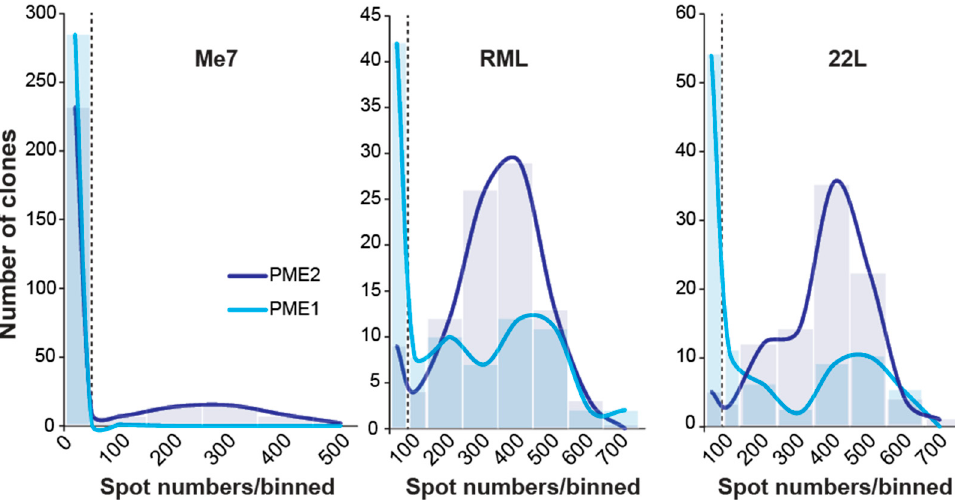
Figure 1. Distribution of prion-infected PME1 and PME2 sublines following infection with Me7, RML and 22L. Cultures of PME1 and PME2 cells were challenged with a 10 − 3 dilution of mouse-adapted prion strain homogenates Me7, RML and 22L (10% w / v ). Cells were split 1:8 twice a week to dilute out the inoculum. After seven passages, limiting dilutions of cells were plated and single cell clones isolated to determine the state of prion infection using the Scrapie Cell assay. A total of 288 Me7-infected clones and 96 RML- and 22L-infected clones were isolated for each of the parental clones PME1 and PME2. To plot the distribution of infected cells per homogenate and cell line, the number of infected cells (spots) were binned into groups of 100 and plotted against the corresponding number of clones; the first two bins contain 0–50 and 50–100 spots. The dashed line at 50 spots denotes a cut-o ff value for scoring infected cells over background.